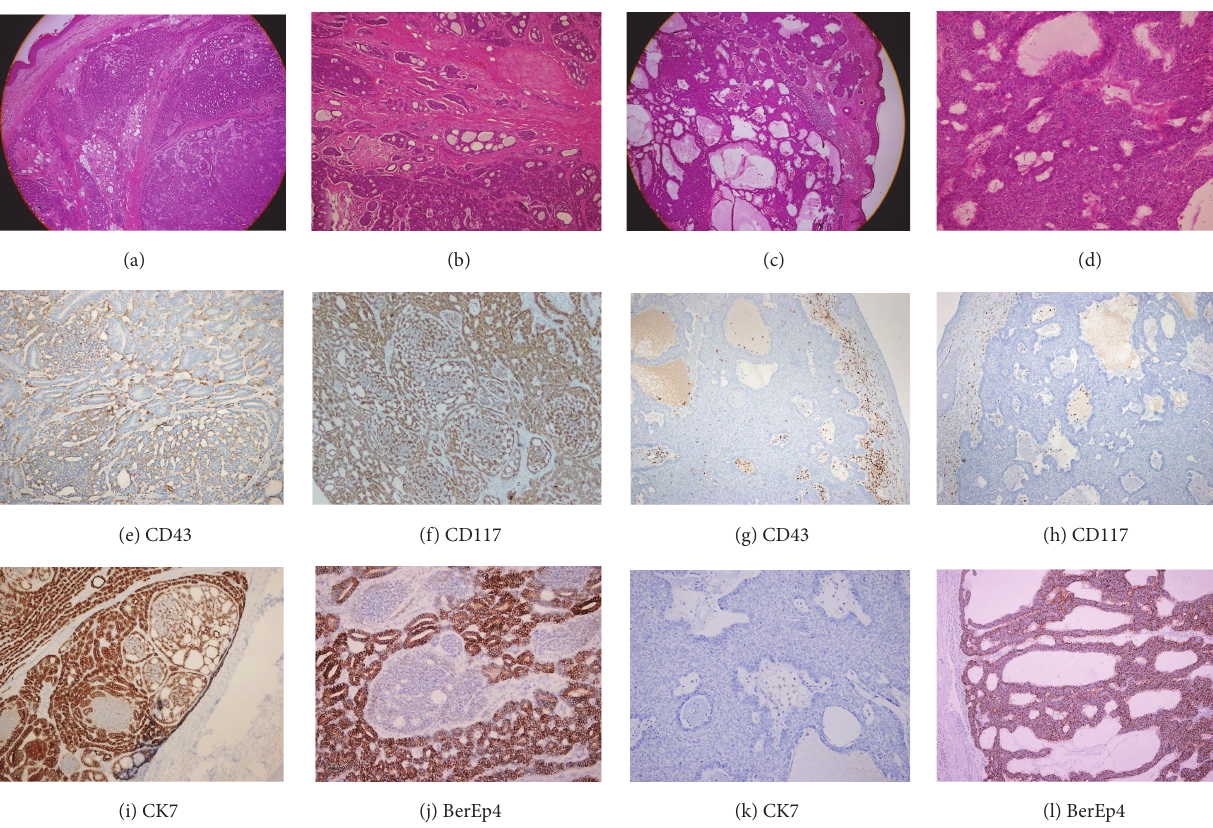
Figure 1: Primer cutaneous adenoid cystic carcinoma (PCACC) (left two columns). Adenoid basal cell carcinoma (A-BCC) (right two columns). (a-b). Typical regular cribriform pattern is readily detected in PCACC. (c-d). However, pseudoluminal areas are not regular, and the well-defined cribriform patterns are not seen in A-BCC. CD117 (f) and CK7 (i) are positive in PCACCs but not in A-BCC (h, k). CD43 positivity is heterogenoeus in PCACC (e) but no positivity is detected except for inflammatory cells in A-BCC (g). BerEp4 positivity is seen in both lesions (j, l). A-BCC shows diffuse positivity (l), but only ductal cell positivity in PCACC (j). Original magnifications: (a, c) × 40; (b, e, f, g, h, i, k, l) × 100; (d, j) ×